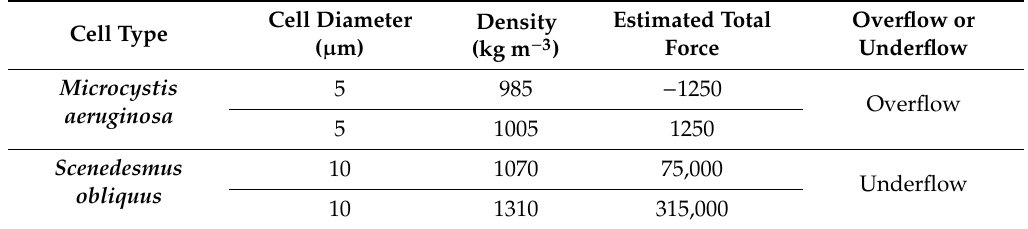
Table 1. Estimated total force calculations from cell densities and cell diameter for Microcystis and Scenedesmus and the resulting outlet for the cells after separation with the